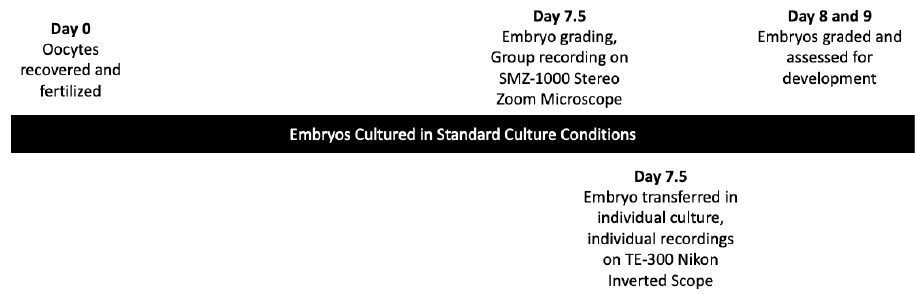
Figure 1. Timeline of events to collect embryo developmental outcomes and video